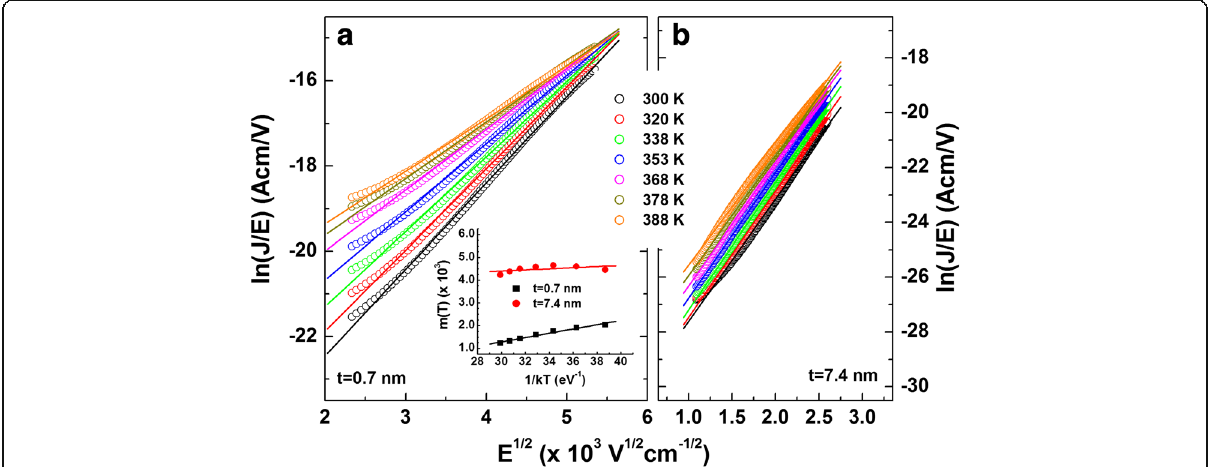
Fig. 10 Poole – Frenkel (PF) emission plots of ln( J / E ) vs. E 1/2/ with the linear fit to the experimental data for the sample with a 0.7- and b 7.4-nm-thick AlN. The inset in a presents the calculated m ( T ) values vs.